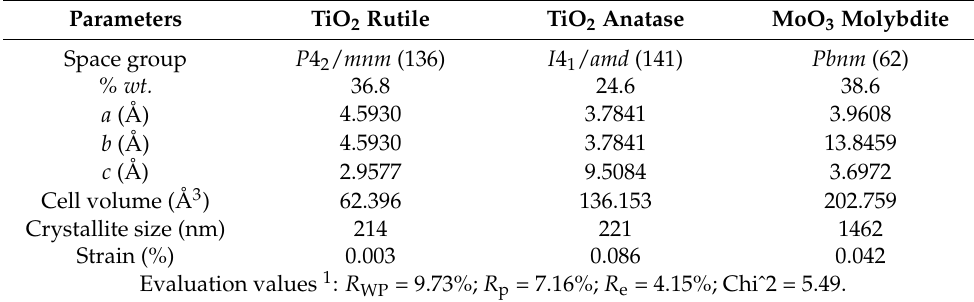
Table 1. Rietveld refinement results of the